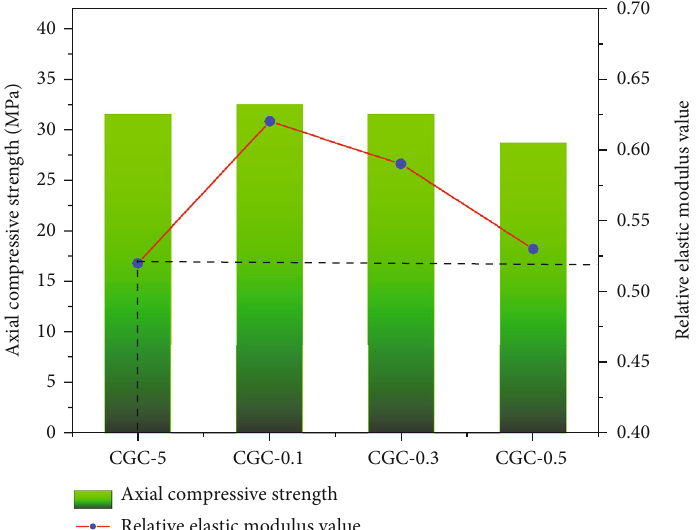
Figure 11: Axial compressive strength and elastic modulus of PET fi ber-reinforced coal gangue fi ne aggregate